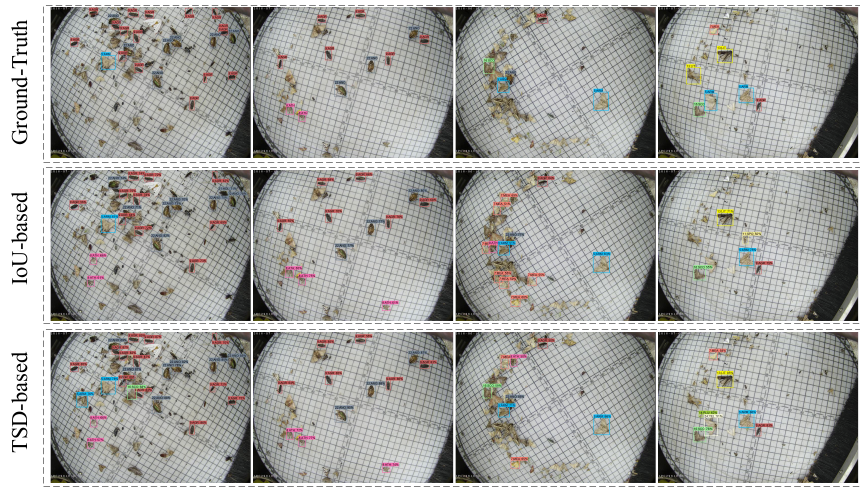
Figure 9. The visualization results based on IoU metrics and TSD metrics. The first row represents the ground truth of the dataset, and the second row represents the results under IoU, while the third row represents the results under the proposed